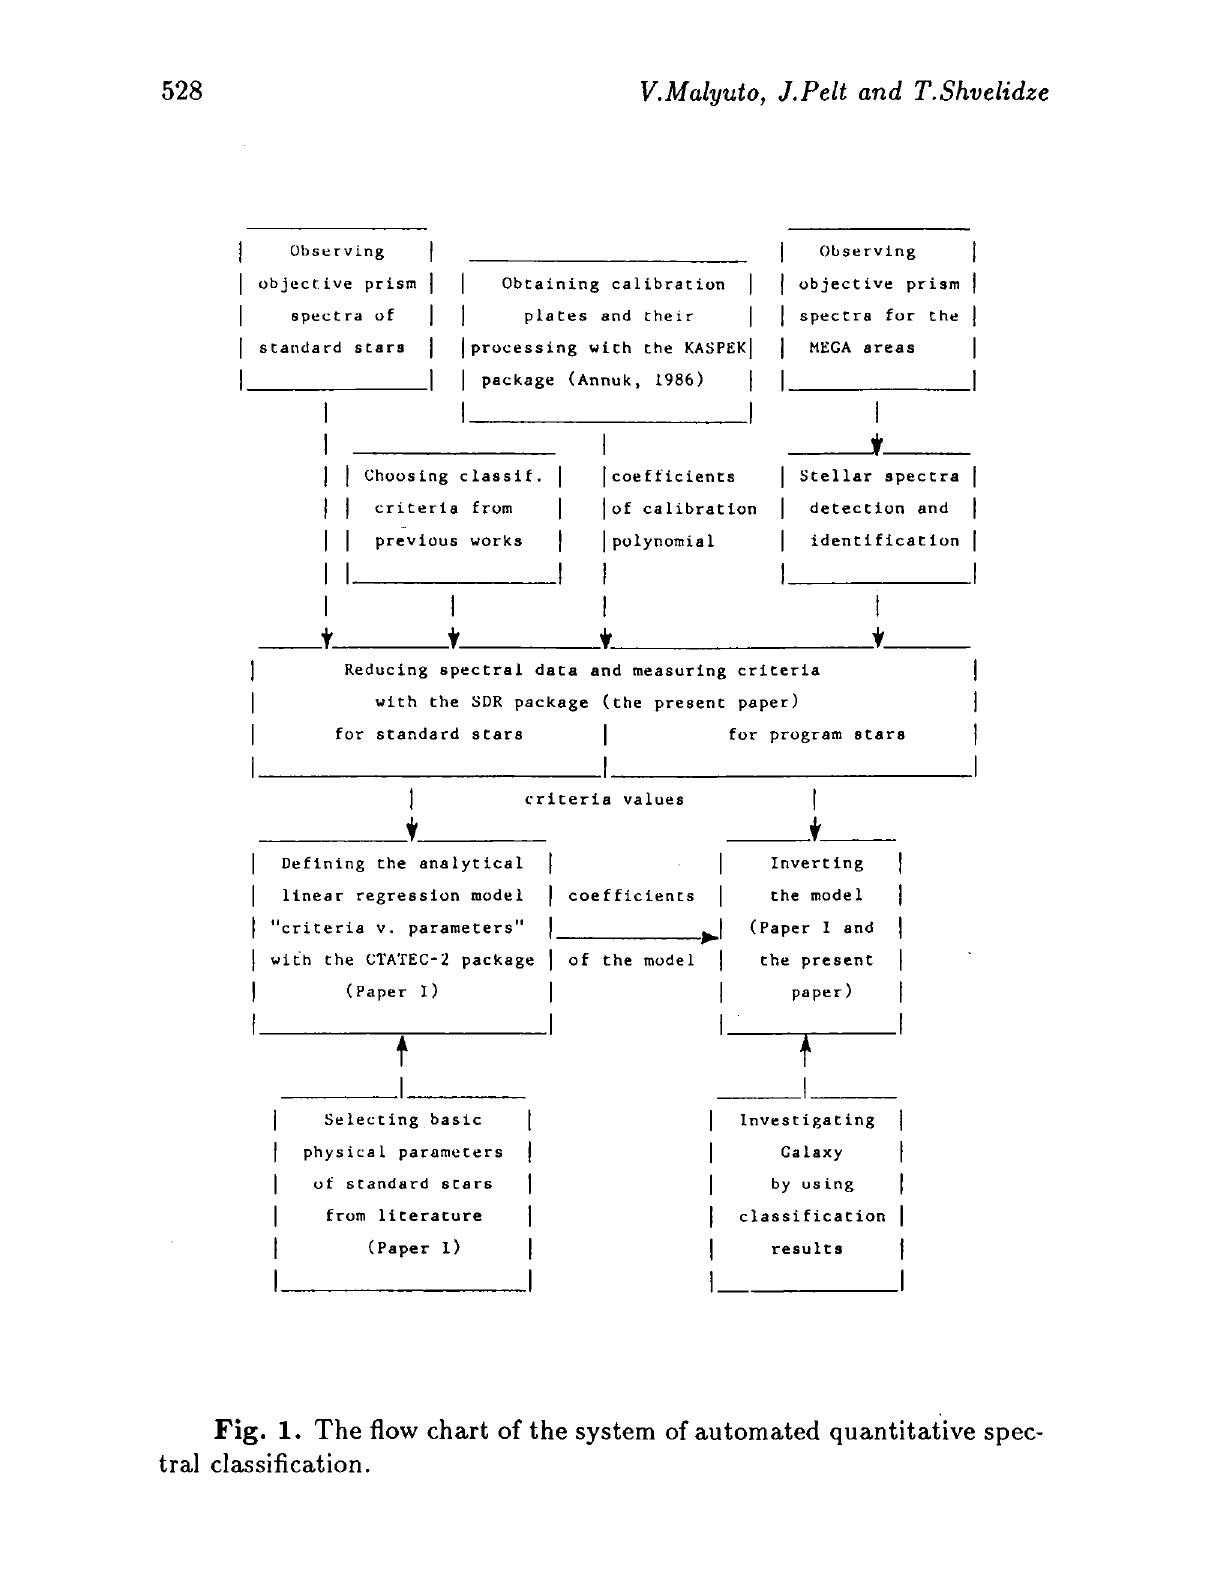
Fig. 1. The flow chart of the system of automated quantitative spec- tral